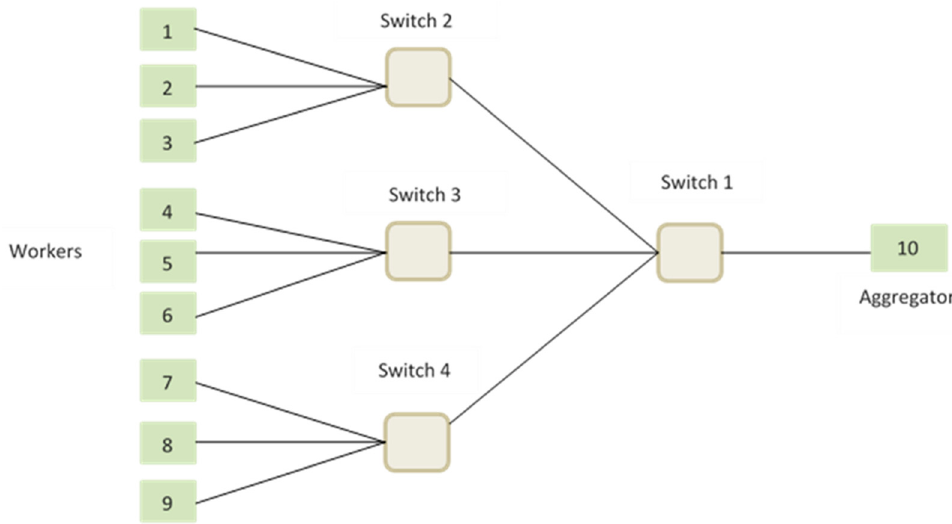
Figure 5. Network topology.